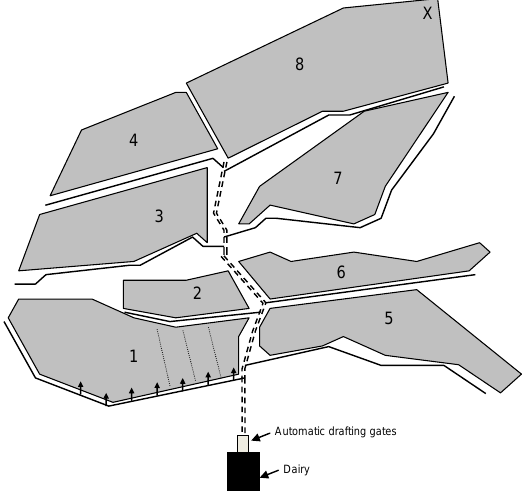
Figure 1. Camden AMS milking platform showing the location of the dairy, multi-direction laneways (dashed line) and single direction laneways (solid line). The point marked with an “X” is 1.2 km from the